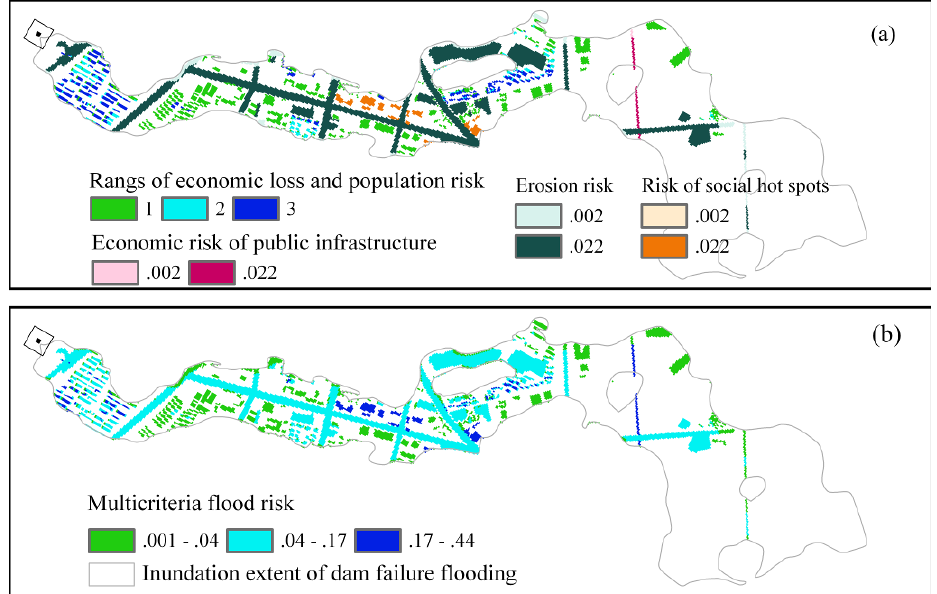
Figure 7. (a) Flood risk of each indicator and (b) multicriteria flood risk under existing conditions. Economic-loss risk (yuan/year/cell) and population at risk (person/year/cell) were classified into the three following ranges: 1 (2 < economic loss risk < 100 or population at risk < 0.002); 2 (100 ≤ economic loss risk < 228 or 0.002 ≤ population at risk < 0.007); and 3 (228 ≤ economic loss risk ≤ 490 or 0.007 ≤ population at risk <